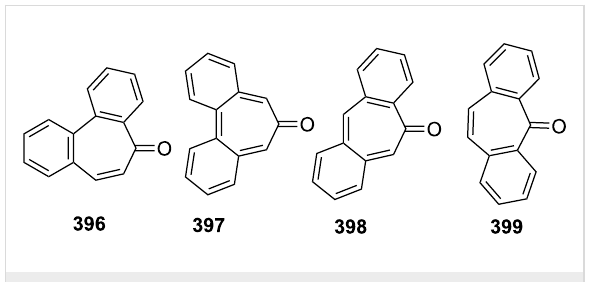
Figure 19: Four possible isomers of dibenzotropones 396 – 399 .